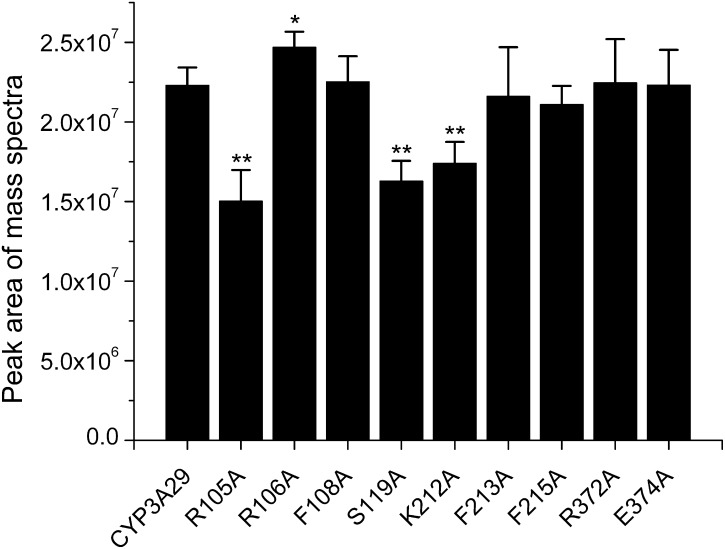
The peak area of the mass spectra of 3′-OH-T-2 generated by CYP3A29 metabolizing T-2 toxin.The data were expressed as means ± standard deviations (error bars) (n = 3). **(p<0.01) and *(p<0.05) indicate statistically significant difference between the wild-type CYP3A29 and each mutant.